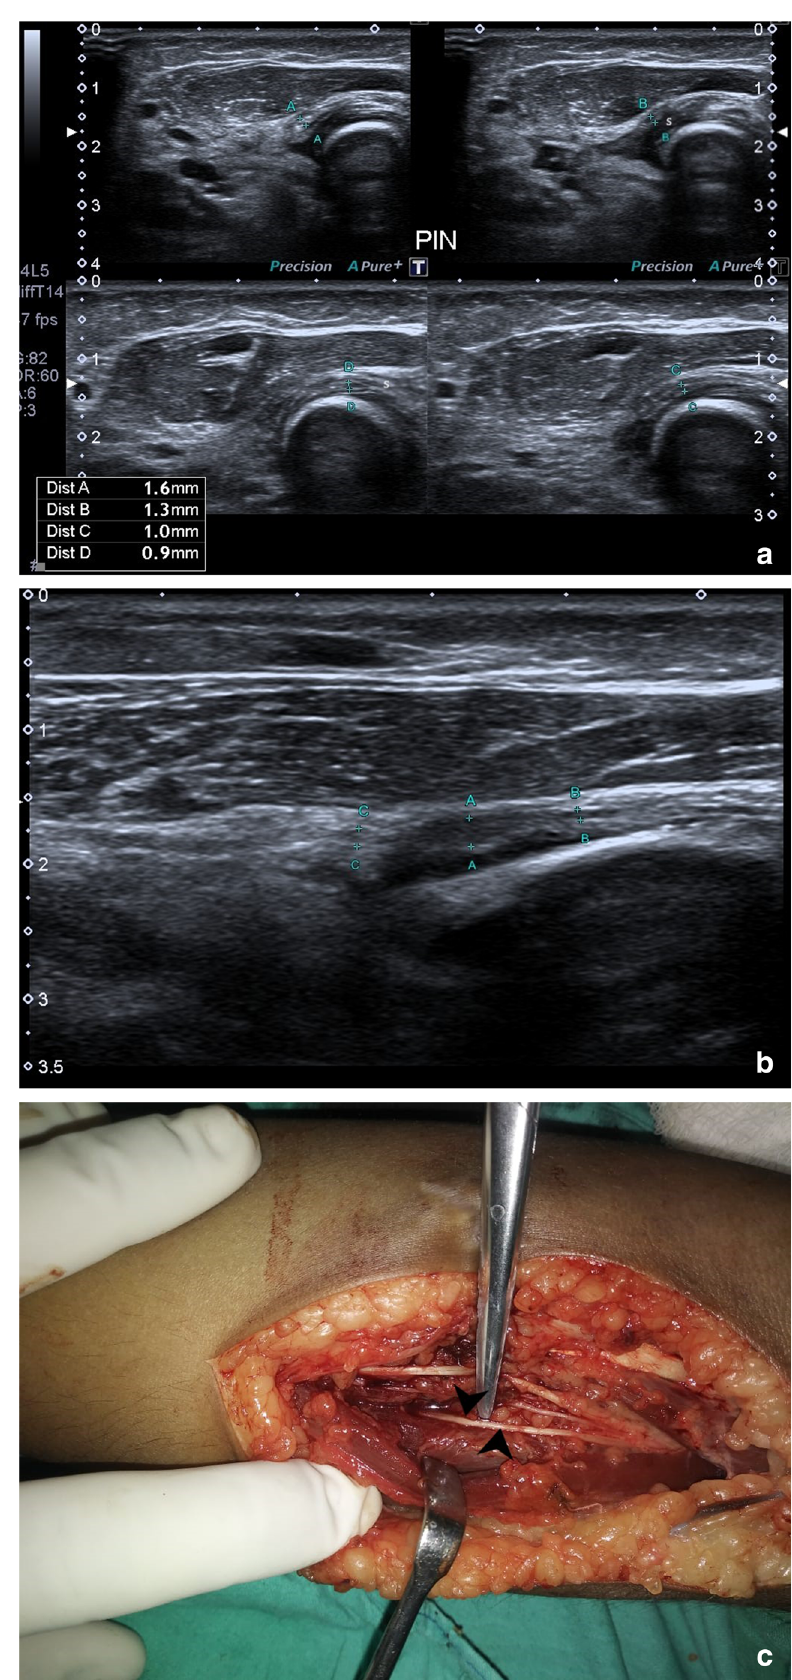
Fig. 7 a Normal posterior interosseous nerve can be seen winding around the radial head, passing between two heads of the supinator (s) in to the forearm. The nerve is of normal calibre and echogenicity (A,B,C and D). b Just distal to 7a, focal increase in calibre and hypo-echogenicity (marker A) is noted in PIN.